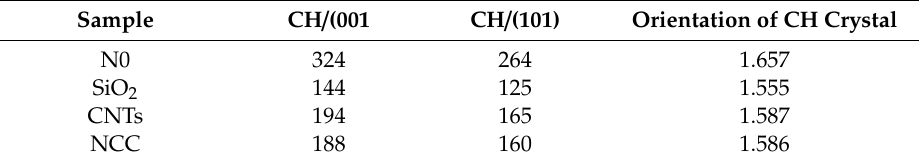
Table 4. CH crystal orientations of cement reinforced by three nanomaterials at 28 d of age.